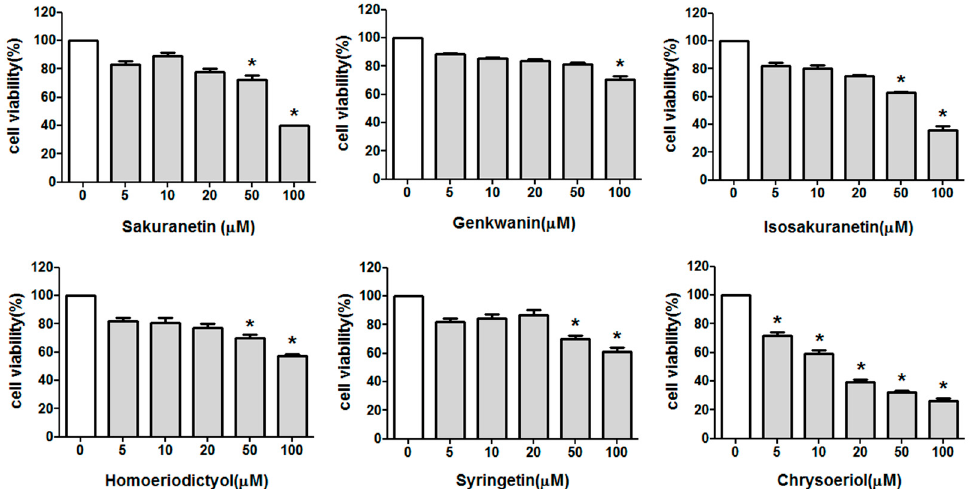
Figure 2. Effect of methoxyflavonoids on the cell viability by MTT assay. HaCaT cells were grown in the culture medium in the presence of various concentrations of methoxyflavonoids for 24 h. Cell viability was measured by MTT assays. All data are given as means ± SD of at least three independent experiments with triplicate samples. * p ˂ 0.05 vs. medium